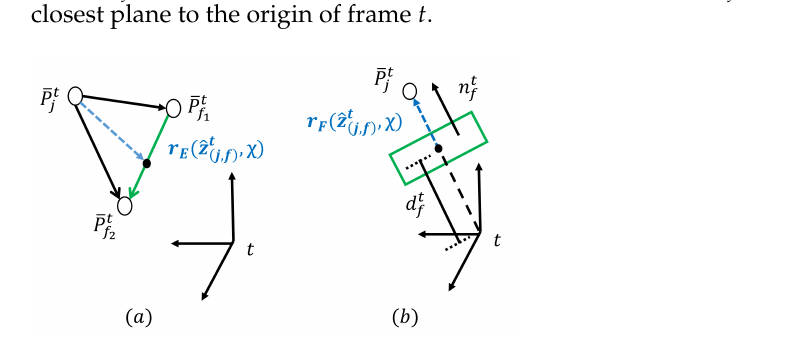
Figure 5. Illustration of residuals for edge and plane features. Residuals are shown by the blue lines. t ( a ) The residual of edge feature P j with the corresponding line shown in green that is formed by P t t and P f 2 . ( b ) The residual of the plane feature P j with the plane shown in green that is formed by the feature